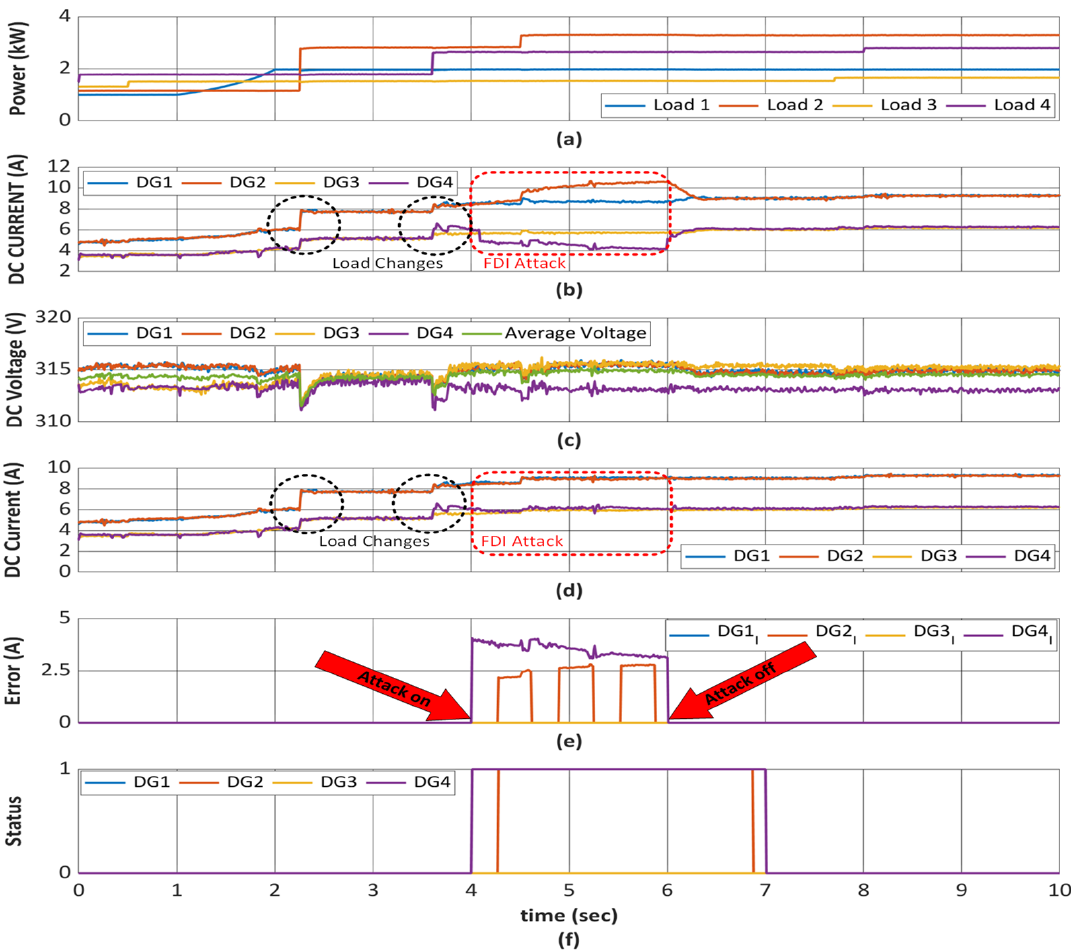
Figure 5. System performance in the presence of current sensor FDIAs: ( a ) Load profiles. ( b ) Output current of a standard secondary controller. ( c ) Output DC voltages with proposed method. ( d ) Output current with proposed method. ( e ) Error signals. ( f ) Final status of DGs in attack presence.